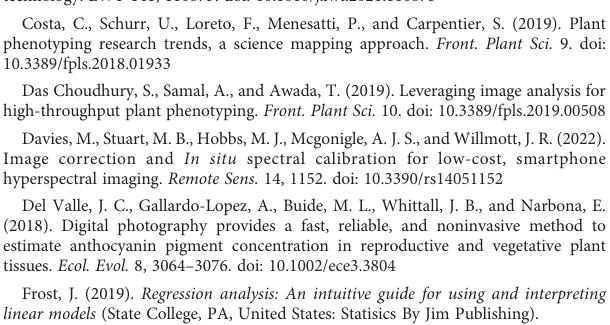
DOCUMENT S1 Manual for image analysis script. SCRIPT S1 Python script for normalized difference anthocyanin index using multispectral